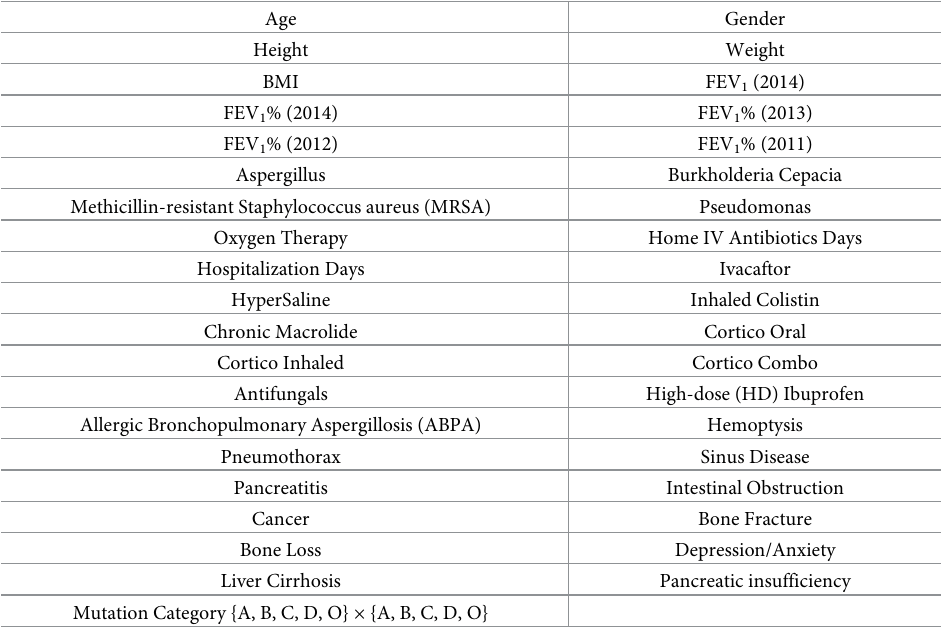
Table 1. Common feature variables considered in the